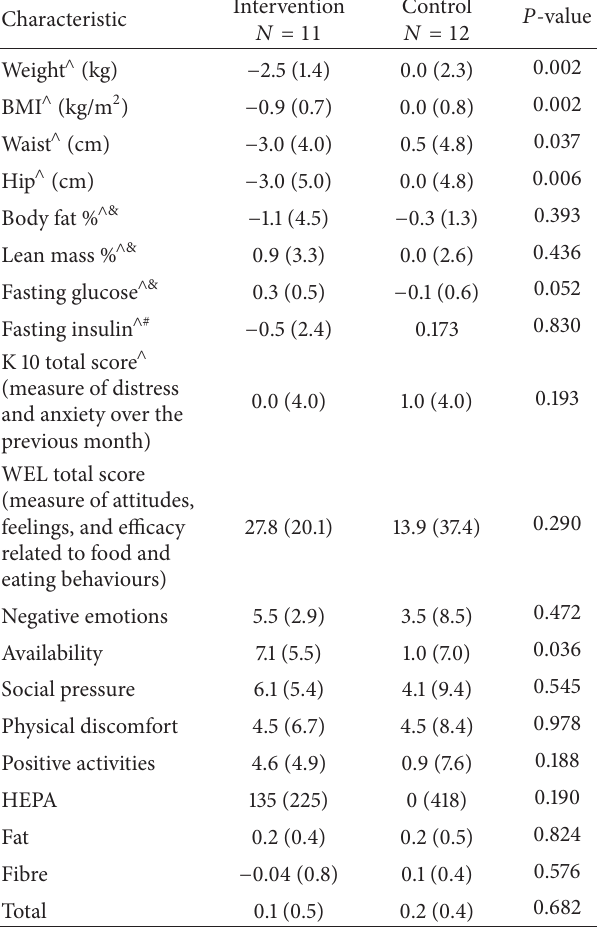
Table 2: Change between 3-month and baseline measurements.